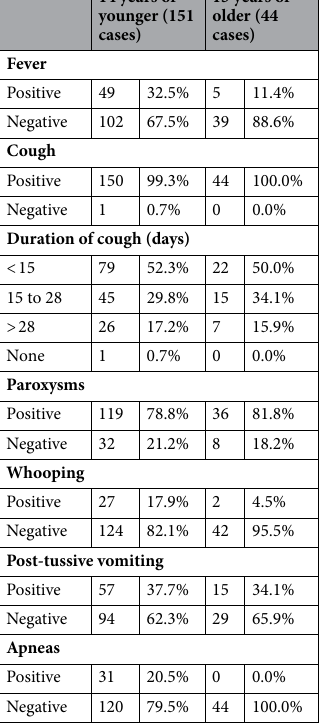
Table 3. Clinical symptoms.